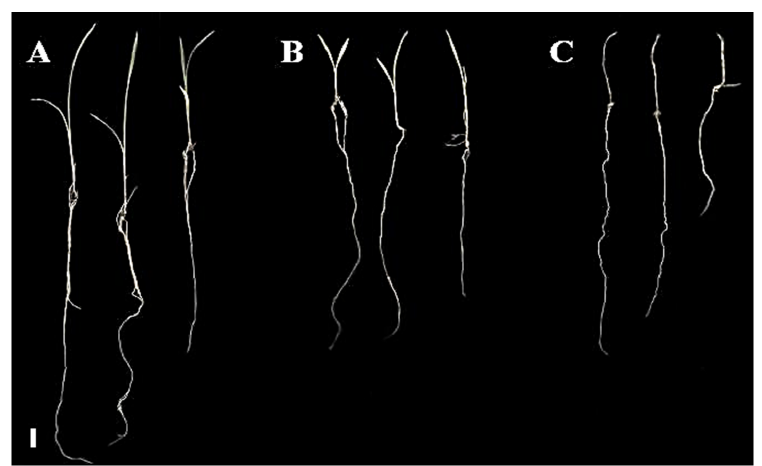
Figure 7. Seedlings of barnyardgrass at the end of 8 days in the leaching bioassay. ( A ) Negative control (plants treated with distilled water); ( B ) plants with aqueous extract (AE) at 4% and ( C ) plants with AE at 10%. Bar = 1 cm.